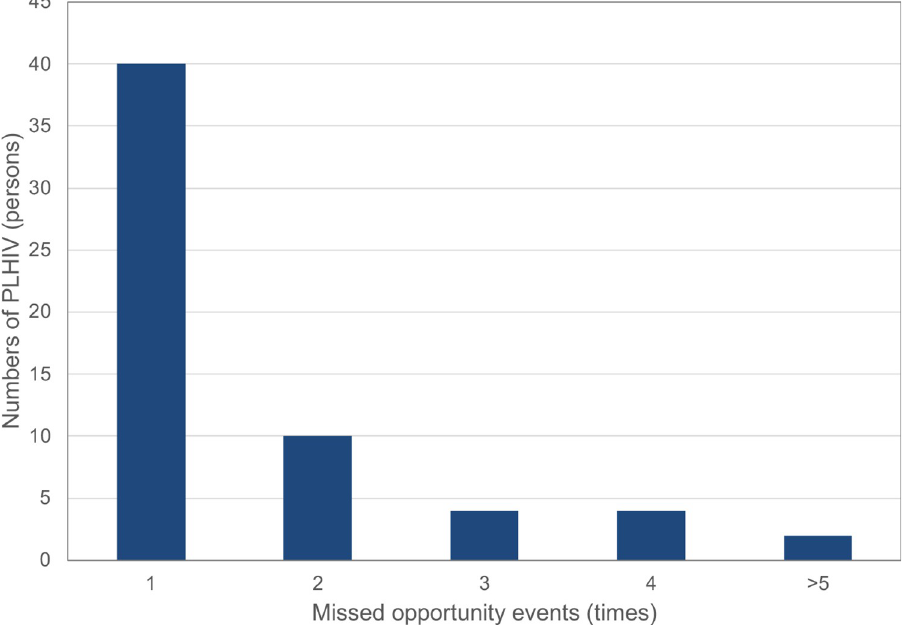
Fig 1. Numbers of missed opportunity events for earlier diagnosis of HIV infection in PLHIV at Ramathibodi and Sawanpracharak hospitals between 2019 and 2020.